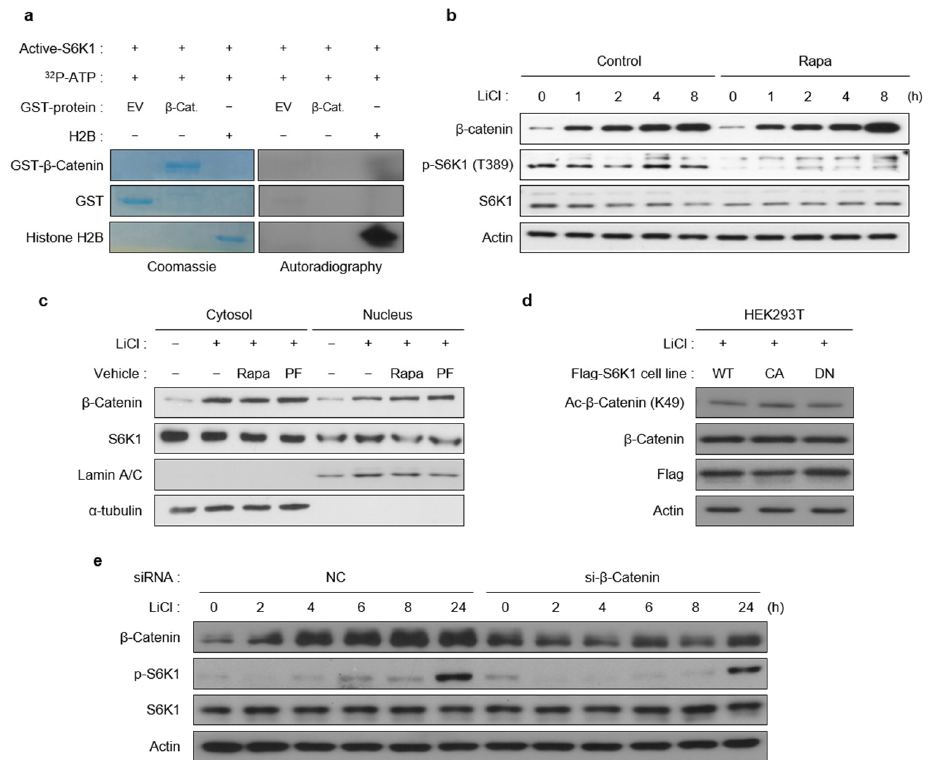
Figure 4. S6K1 does not affect β -catenin. ( a ) β -catenin is not a kinase substrate of S6K1. In vitro kinase assays were performed using GST, GST- β -catenin, and recombinant histone H2B as substrates and recombinant active-S6K1 as the kinase in the presence of 32P-ATP. The presence of substrates was confirmed by Coomassie blue staining ( left ), and 32P-mediated phosphorylation was detected by photosensitization with X-ray film ( right ). ( b ) Inhibition of S6K1 did not influence LiCl-induced β -catenin accumulation. Immunoblotting was performed using 293T cells pretreated with rapamycin (25 nM, 1 h) followed by LiCl (25 mM) for the indicated time points. ( c ) S6K1 inhibition did not affect the nucleocytoplasmic distribution of β -catenin. Immunoblotting was performed using cytoplasmic and nuclear extracts from 293T cells pretreated with or without rapamycin (25 nM) and PF-4708671 (10 µM) for 1 h and then treated with LiCl for 8 h.) ( d ) S6K1 does not affect the acetylation of K49 residue of β -catenin in a kinase activity-dependent manner. Immunoblotting was performed using 293T cells stably expressing Flag-tagged WT, CA, and DN forms of S6K1 treated with LiCl (25 mM) for 8 h. ( e ) β -catenin knockdown did not influence LiCl-induced phosphorylation of S6K1. Immunoblotting was performed using 293T cells treated with LiCl for the indicated time points after transient transfection with β -catenin siRNA (48 h).